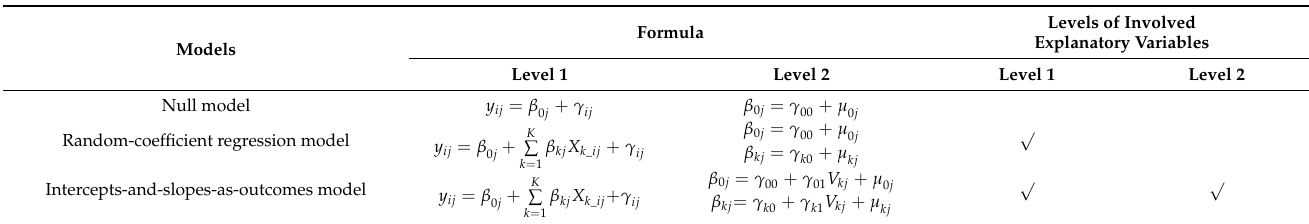
Table 3. Three basic forms of